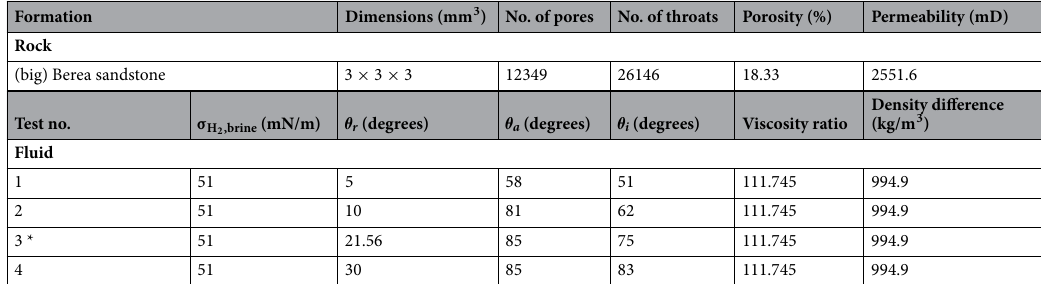
Table 4. Fluid and rock properties used for the wettability sensitivity analysis, by changing advancing ( θ a ) and receding ( θ r ) contact angles. *Indicates the base-case from the literature 2